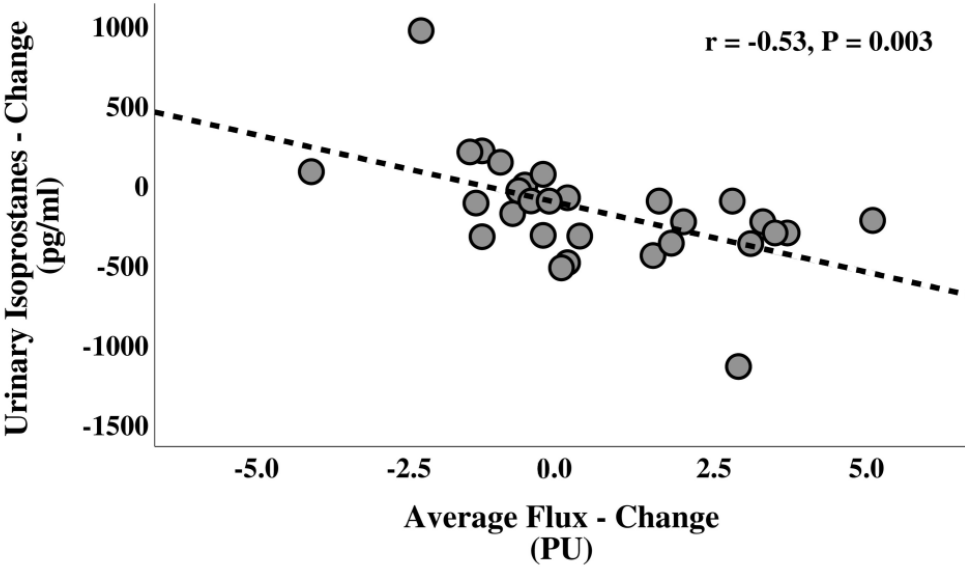
Figure 3. Correlation between changes in the urinary isoprostanes and average microvascular flux in overweight and obese, middle-aged and older adults. Key: p , p value; PU, perfusion unit; r, Pearson’s coefficient of correlation.